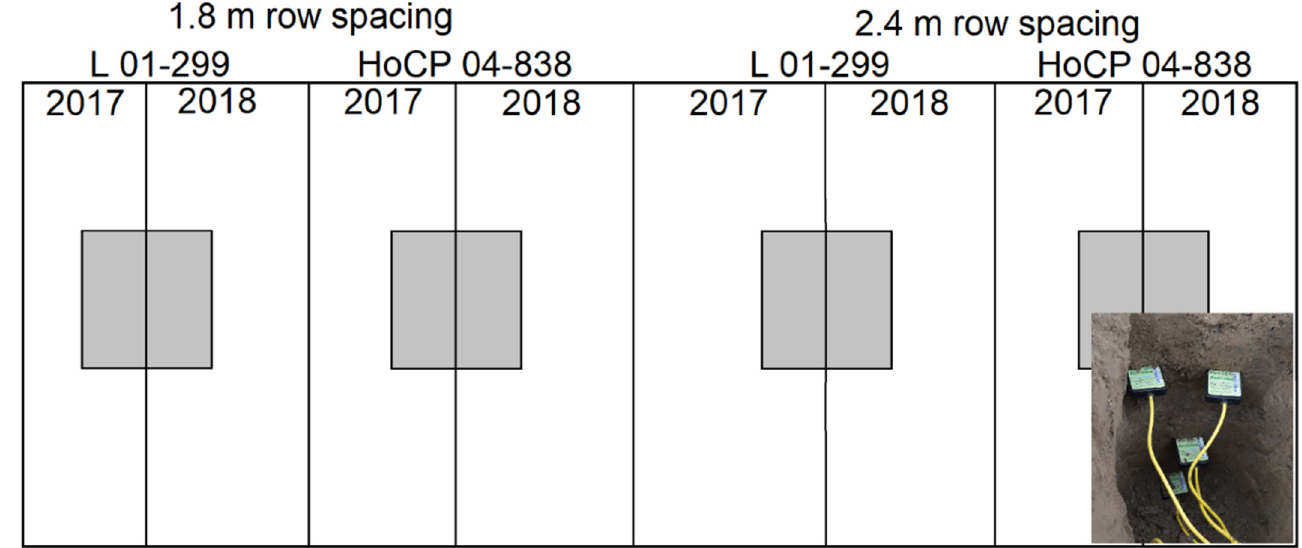
Figure 1. Schematic of the study area, sowing the plots with row spacing, varieties, and plant years included on the top of the plots. The shaded square in the middle of the plots represents the location of the TDR sensors. The location and orientation of the sensors within each trench were added as an inset.